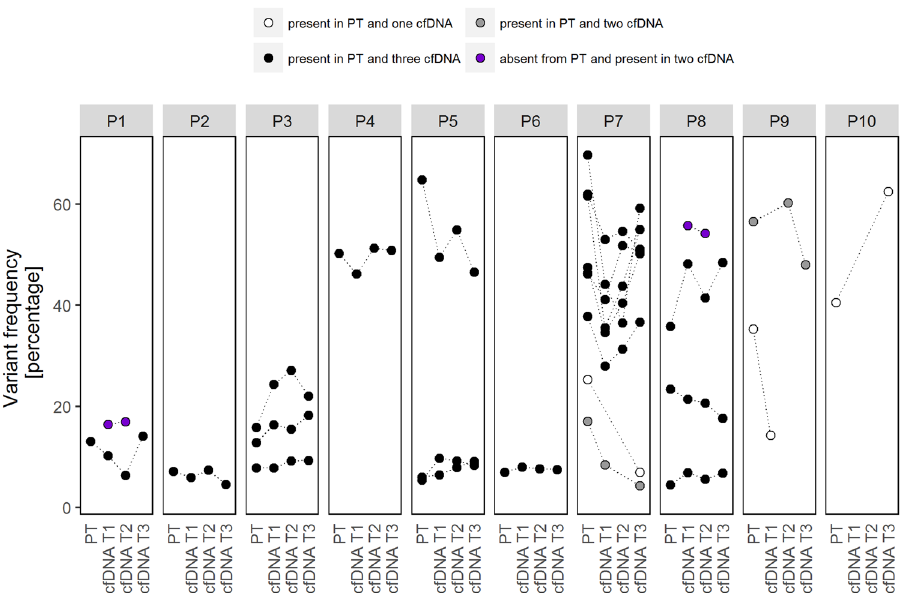
Figure 4. Detection of somatic variants in primary tumor and serum-derived cfDNA specimens. The variant frequency in percentages of somatic variants detected in the primary tumor (PT) and three consecutive cfDNA samples (either T1, T2 or T3) of the ten patients in the study. Recurrent somatic variants at unique genomic positions are connected by lines to visualize variant frequency between replicates. Somatic variants detected in the primary tumor and confirmed in one, two or three patient-matched cfDNA sample in respectively white, grey or black. Somatic variants absent from the primary tumor but detected in two cfDNA sample in